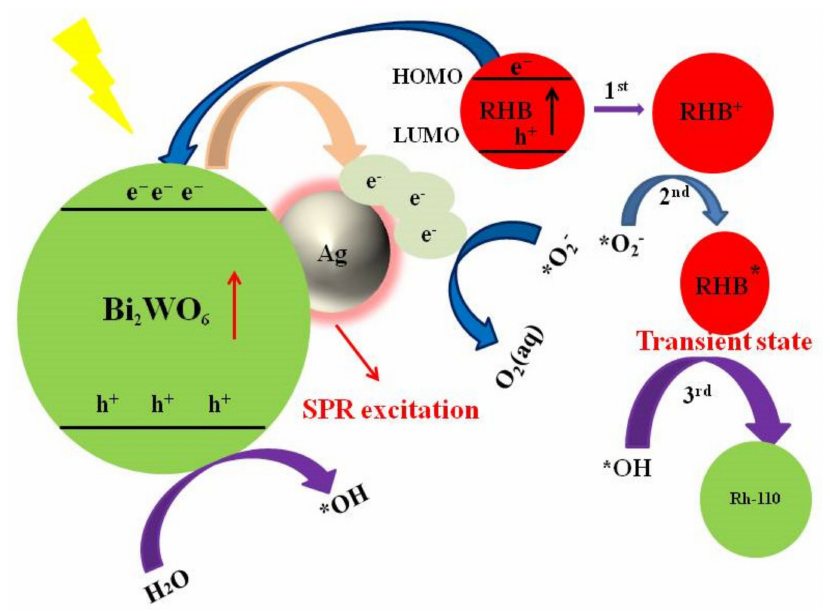
Figure 15. Schematic diagram of the possible process for Ag/Bi 2 WO 6 composites photocatalytic degrading of RhB under visible light